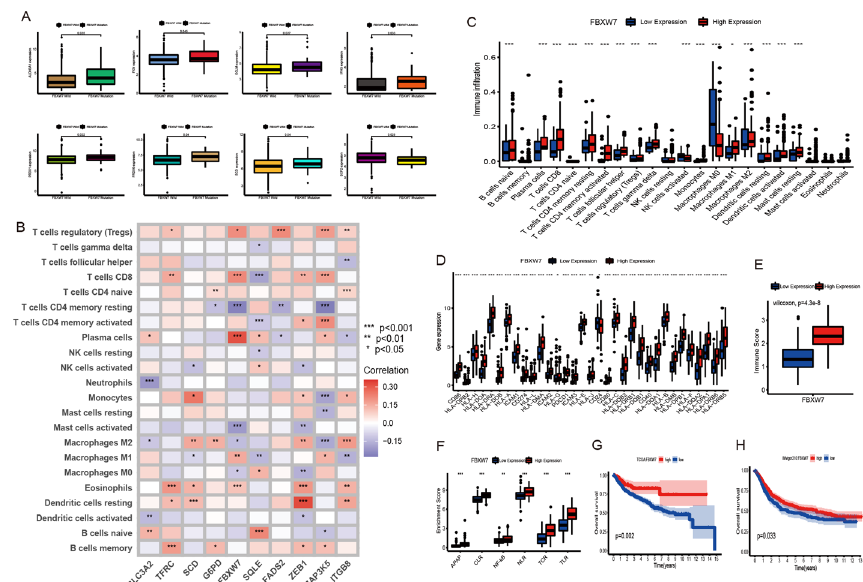
Fig. 4 Correlation between TME infiltration cells and ferroptosis regulators and the roles of FBXW7 in activation of dendritic cells. A Difference in gene expression between FBXW7 mut and wt. B The correlation between TME infiltration cells and ferroptosis regulators. C Difference in the abundance of TME infiltrating cells. D Difference in expression of HLA genes and ICPs. E Difference in immuneScore. F Differences in immune‑activated pathways. G , H Survival analyses for patients in TCGA ( G ) and anti‑PD‑L1 ( H ) immunotherapy cohort (*p < 0.05; **p < 0.01; ***p <